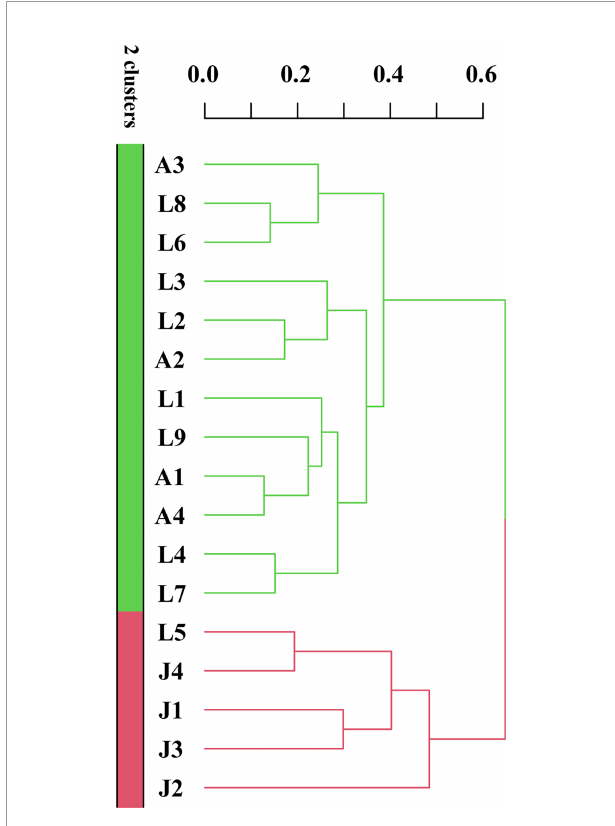
FIGURE 7 | Cluster analysis of seventeen sediment samples from the three sea areas of the Qingdao coast based on Bray – Curtis distance of dinocysts.